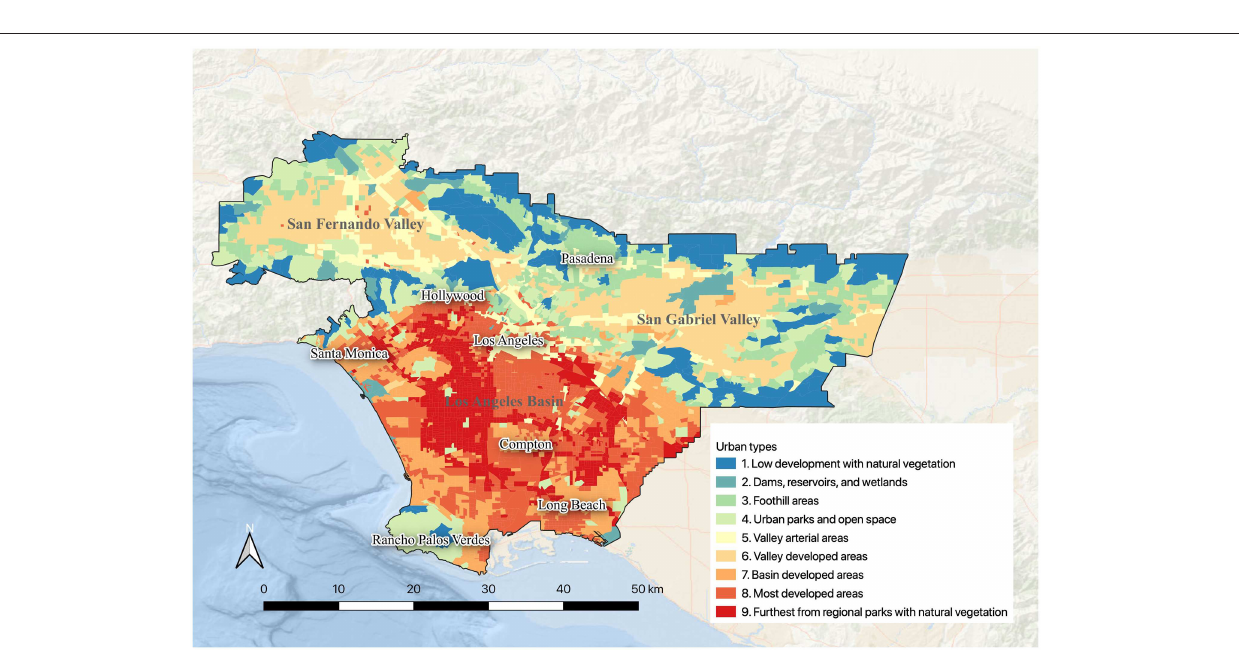
FIGURE 4 | Spatial layout of the nine urban habitat types in the study area. These nine urban habitat types were identified from hierarchical clustering of 18